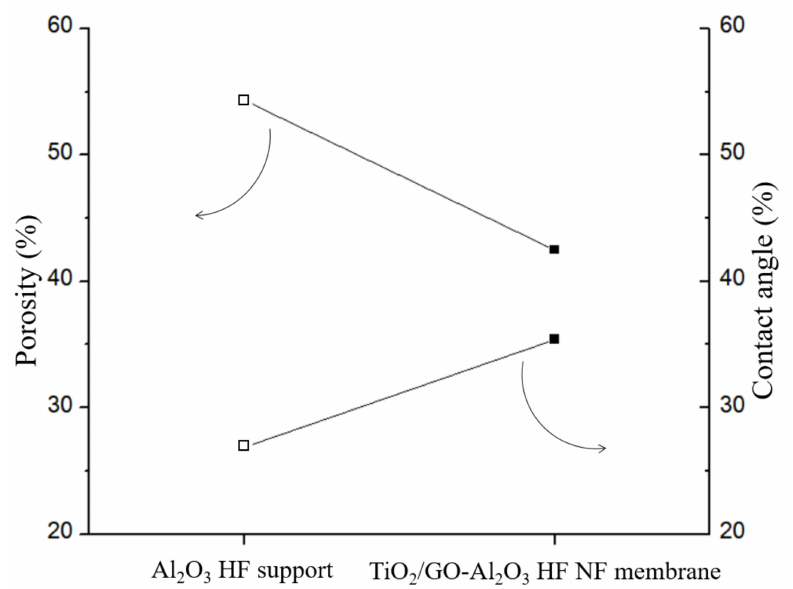
Figure 6. Porosity variation (%) and water contact angle variation (%) between Al 2 O 3 HF support and TiO 2 /GO-Al 2 O 3 HF NF